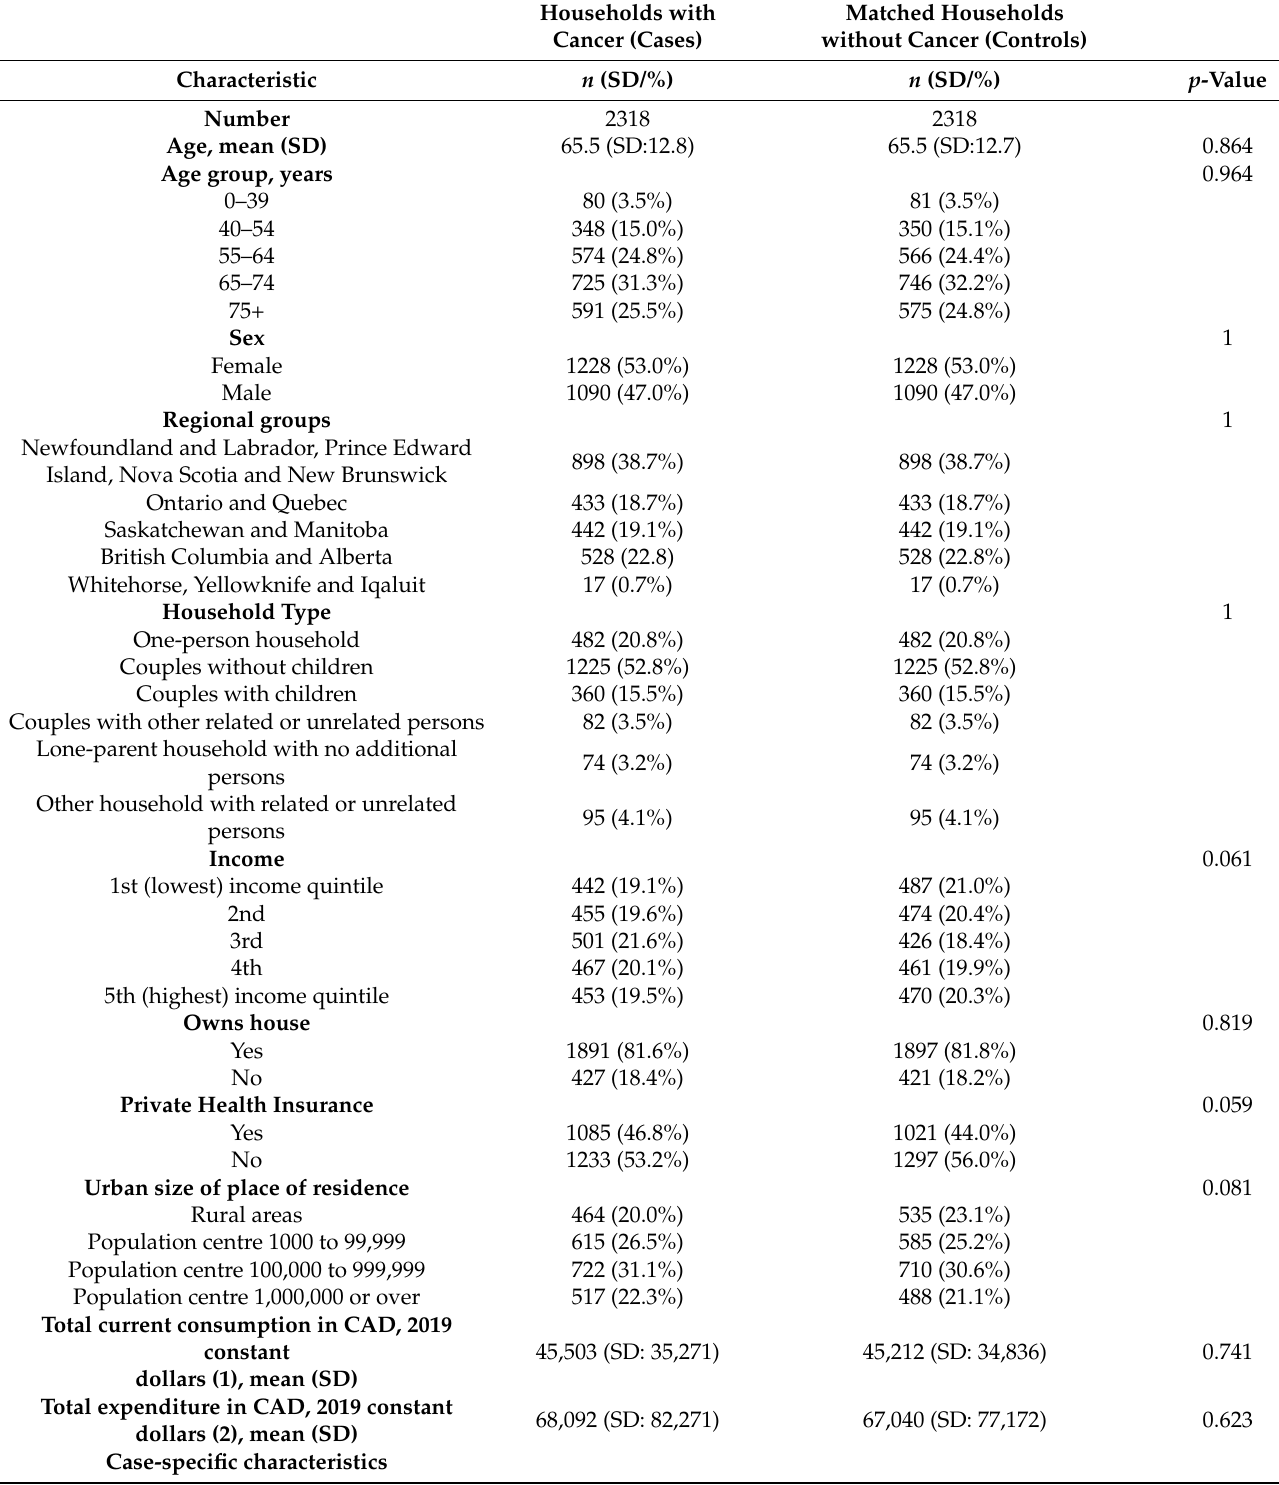
Table 2. Characteristics of respondents and households with and without cancer. Households